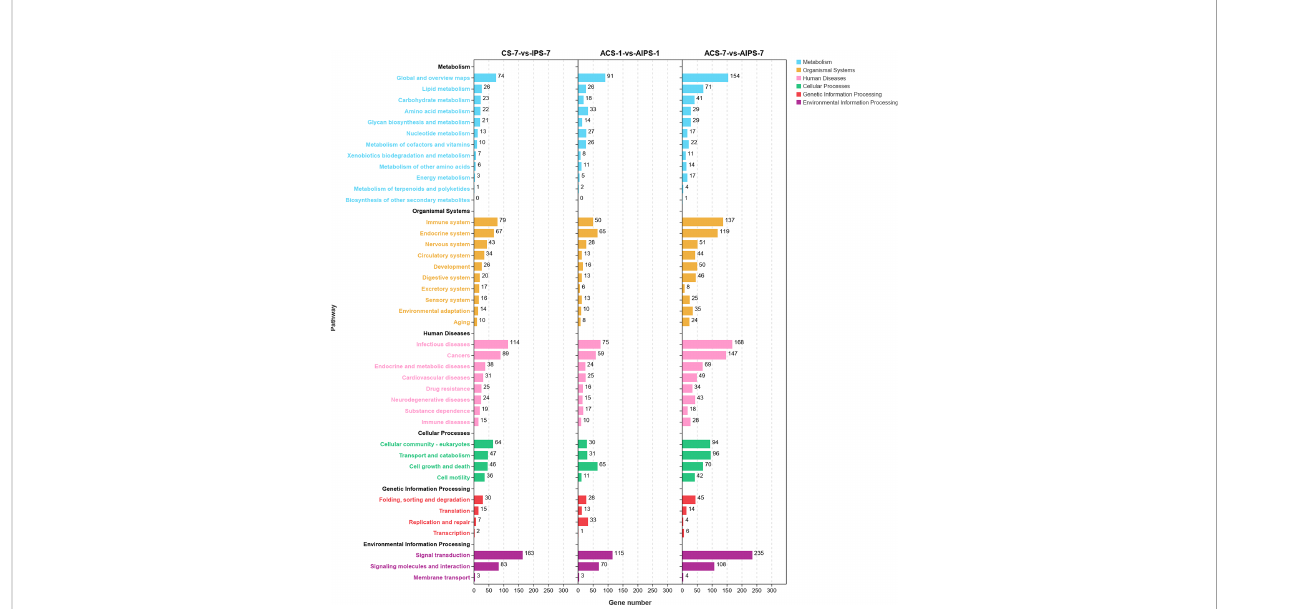
FIGURE 6 Kyoto Encyclopedia of Genes and Genomes (KEGG) enrichment analysis of DEGs at 7 th post immunization day and 1 st and 7 th post challenge day. The enriched pathways were counted in terms of level 1 and 2 classi fi